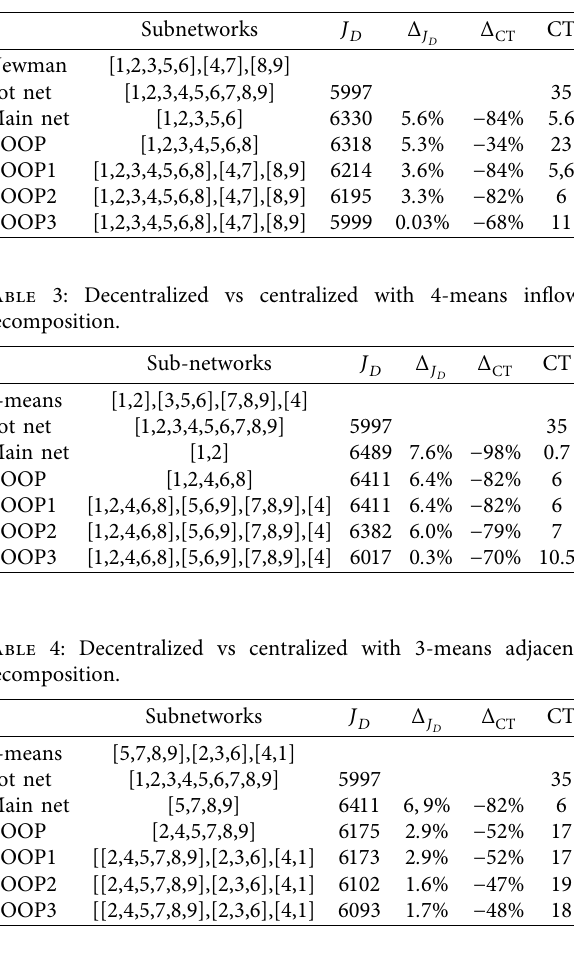
Figure 6: Clustering individuated by 4-means partition. (a) 4-means clustering. (b) Priority process. Table 2: Decentralized vs centralized with Newman decomposition.